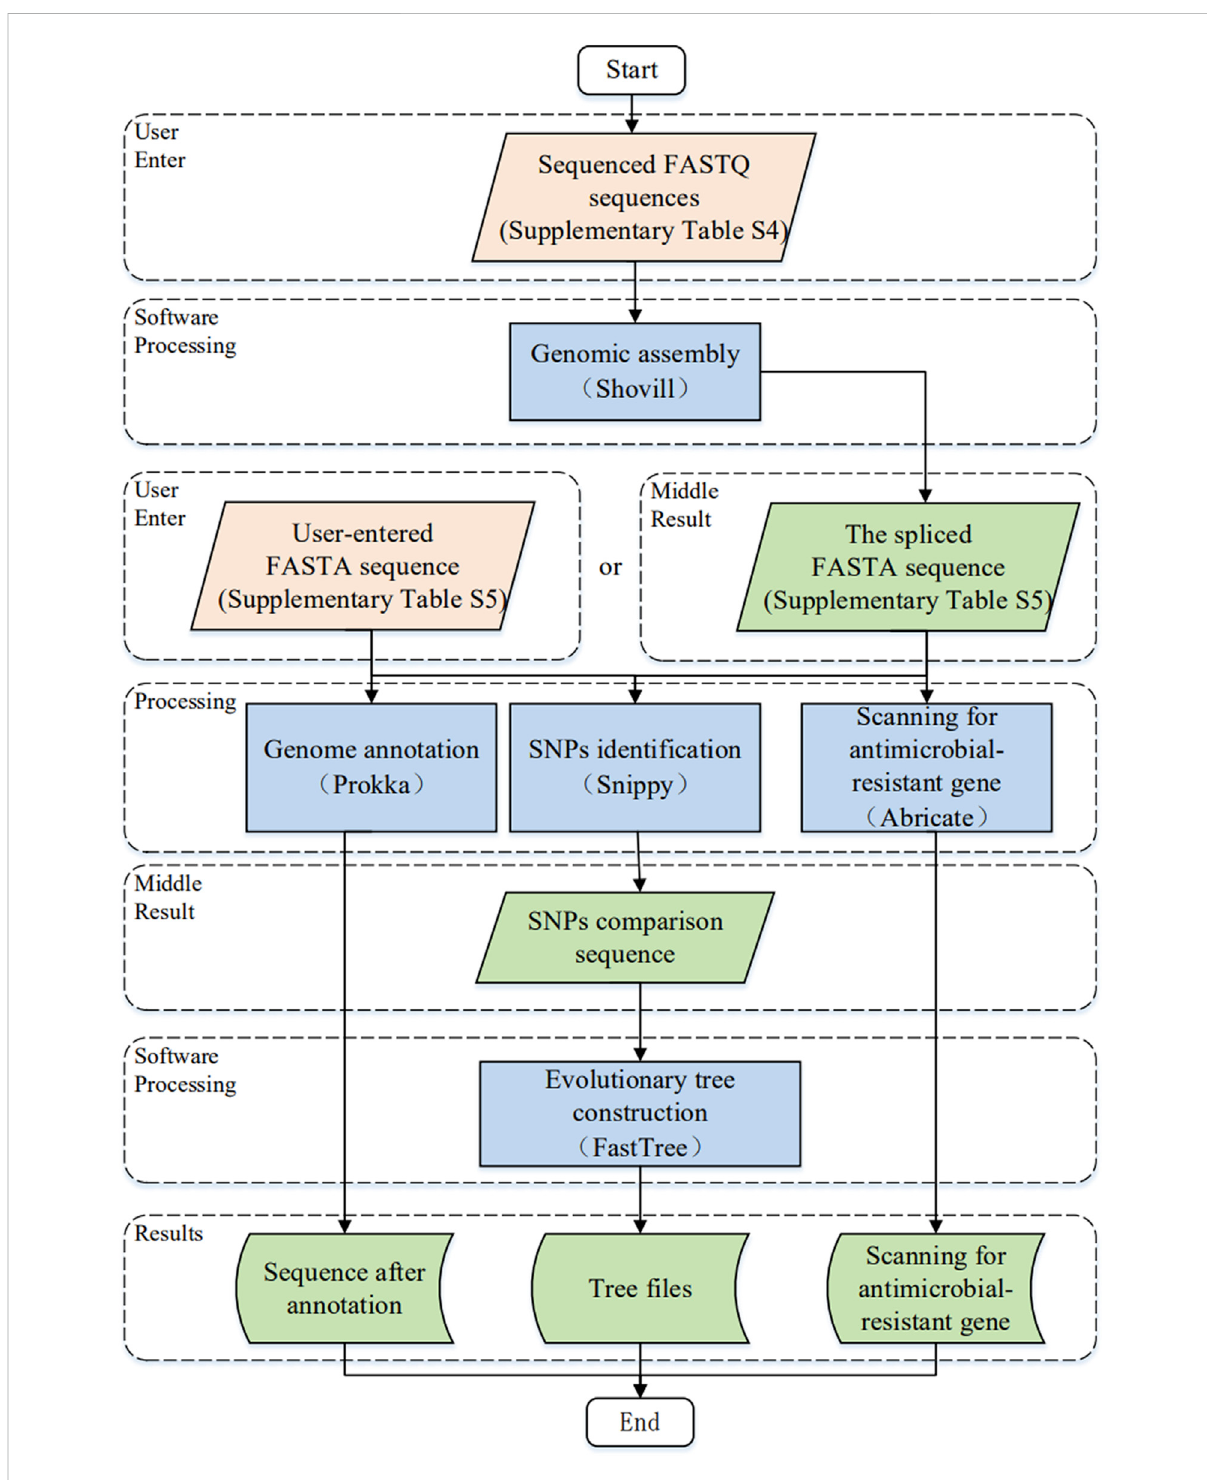
FIGURE 3 The work fl ow for software module